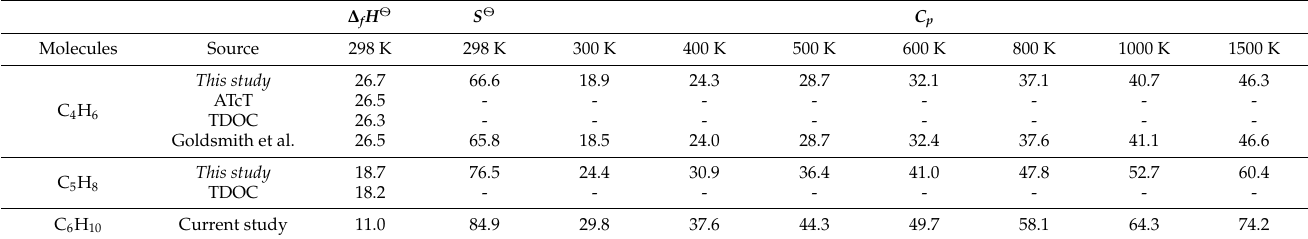
Table 6. Thermochemistry comparison of allylic radicals. (Units: kcal mol − 1 for ∆ f H Ө , cal K − 1 mol − 1 for S Ө and C p ). ∆ Ө S Ө C f H Radicals Source 298 K MultiWell C 4 H 7 1-3 PAPR MultiWell